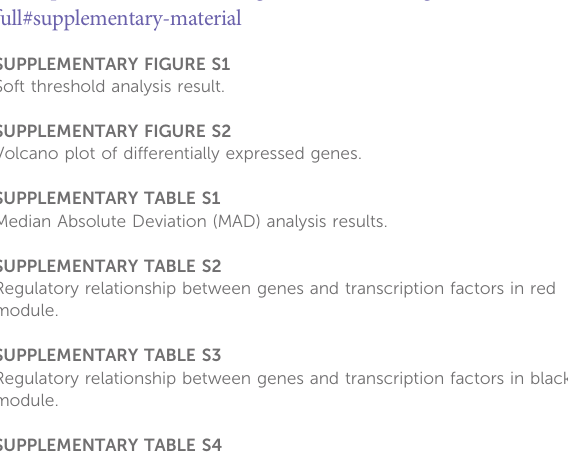
SUPPLEMENTARY FIGURE S1 Soft threshold analysis result. SUPPLEMENTARY FIGURE S2 Volcano plot of differentially expressed